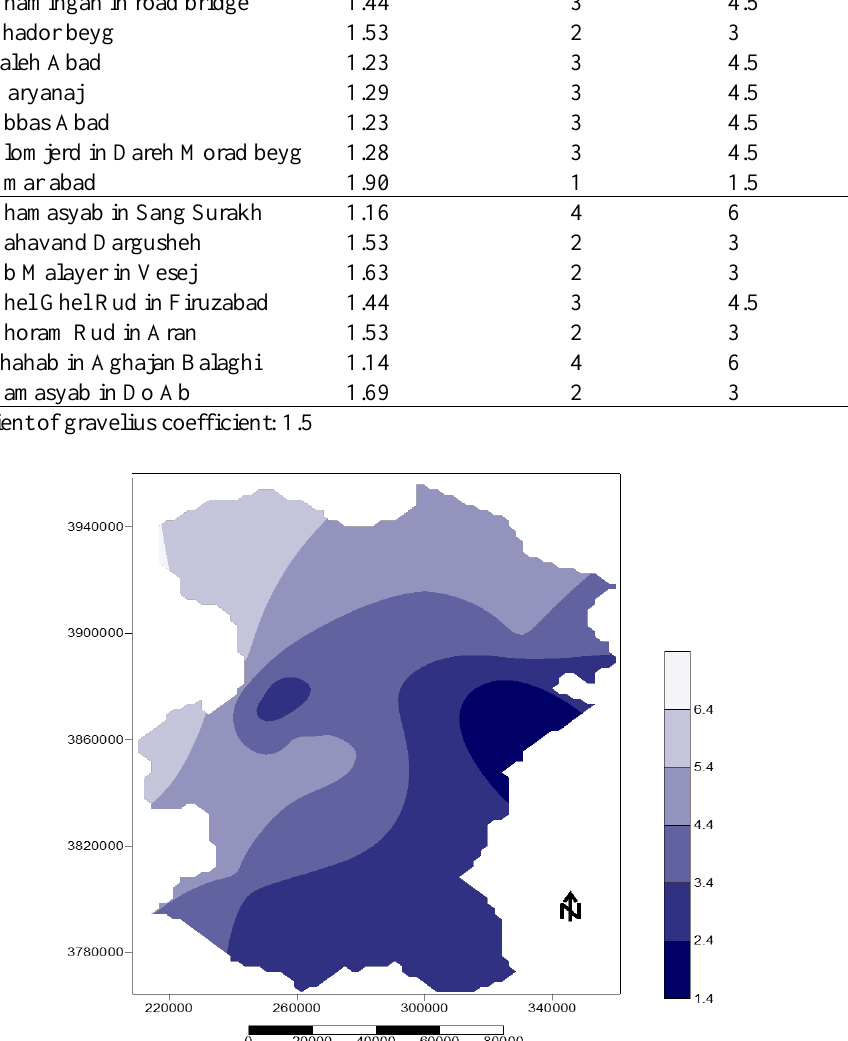
Fig. 5. Zoning of gravelius coefficients of Gamasyab and Gharechay